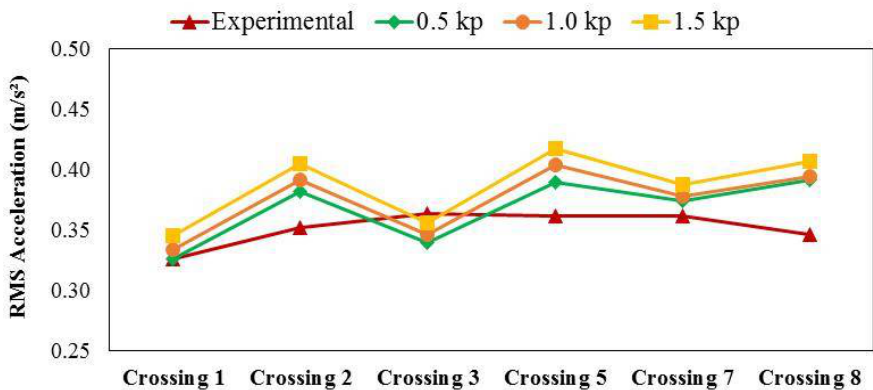
Figure 11. Results from changes in the modal damping. Figure 12. Results from changes in the modal Figure 12. Results from changes in the modal stiffness.